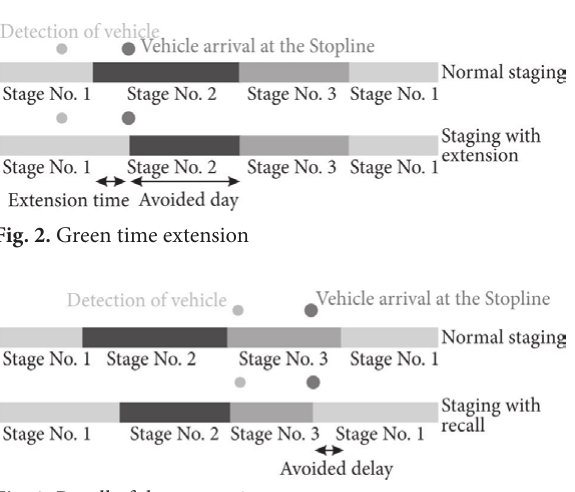
Fig. 3. Recall of the competing stage